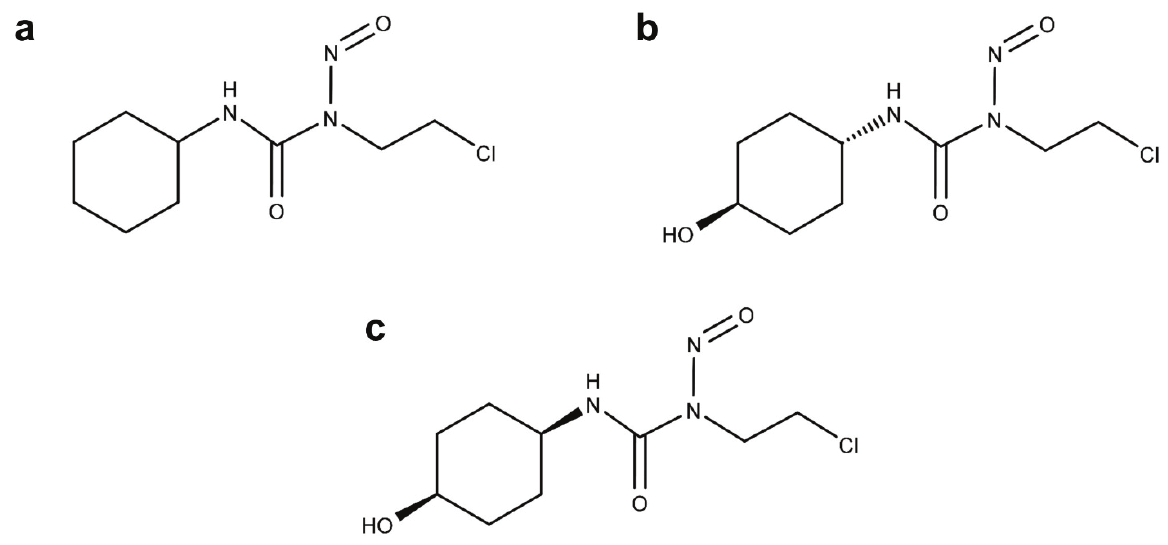
Figure 1. Chemical structure of lomustine ( a ), trans-4-hydroxylomustine ( b ) and cis-4-hydroxylomustine ( c